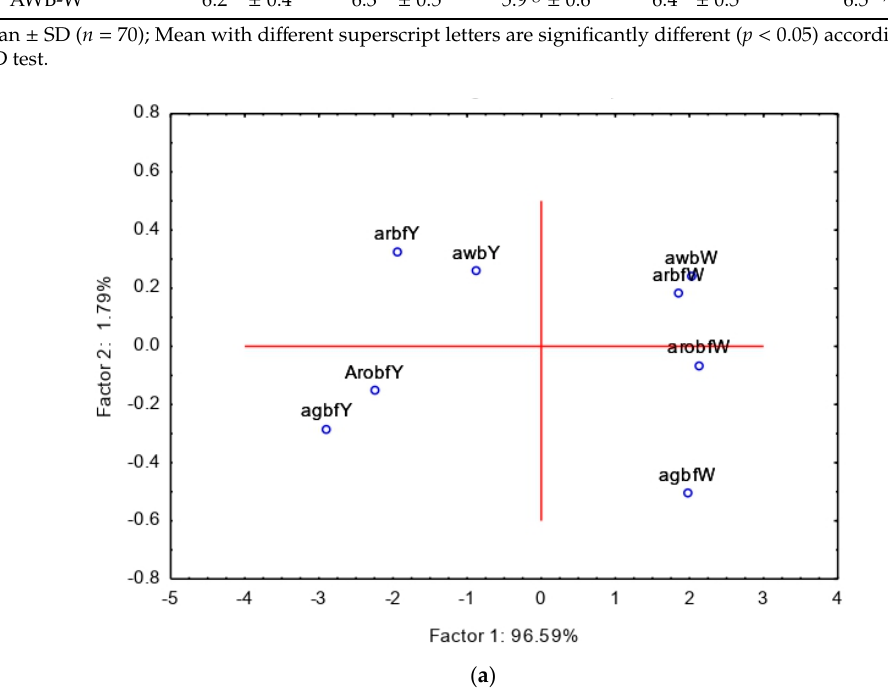
Table 5. Consumer acceptability of amahewu samples.